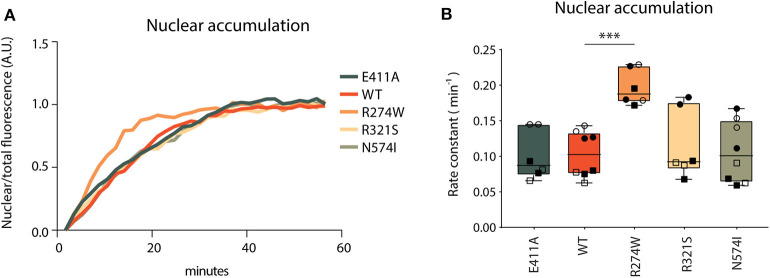
Nuclear accumulation. (A) Nuclear accumulation of STAT1-GFP signal over a 60 min time-lapse in stable STAT1 expressing HeLa cells, each sample was normalized on its last data point. Representative image of non-normalized data is reported in Supplementary Figure 6. Since the Y701A control cannot be phosphorylated, the lack of nuclear accumulation is in line with expectations and no curve fitting was possible for this mutant (Supplementary Figure 6; dotted gray line). (B) Nuclear accumulation rate constants, calculated as described in section Methods. The experiment was repeated at least two times for each STAT1 cell line and each biological repeat is represented by a different symbol. Statistical analysis was performed by comparing each other sample with STAT1 WT using One-Way ANOVA with Dunnett's post-hoc test. Data are represented in box and whiskers plot, with all data points shown. ***P < 0.001.